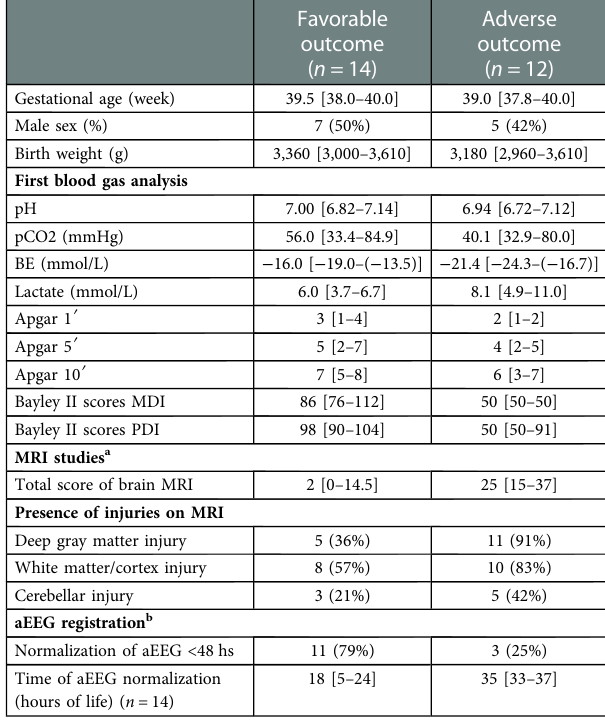
TABLE 1 Baseline characteristics of the study